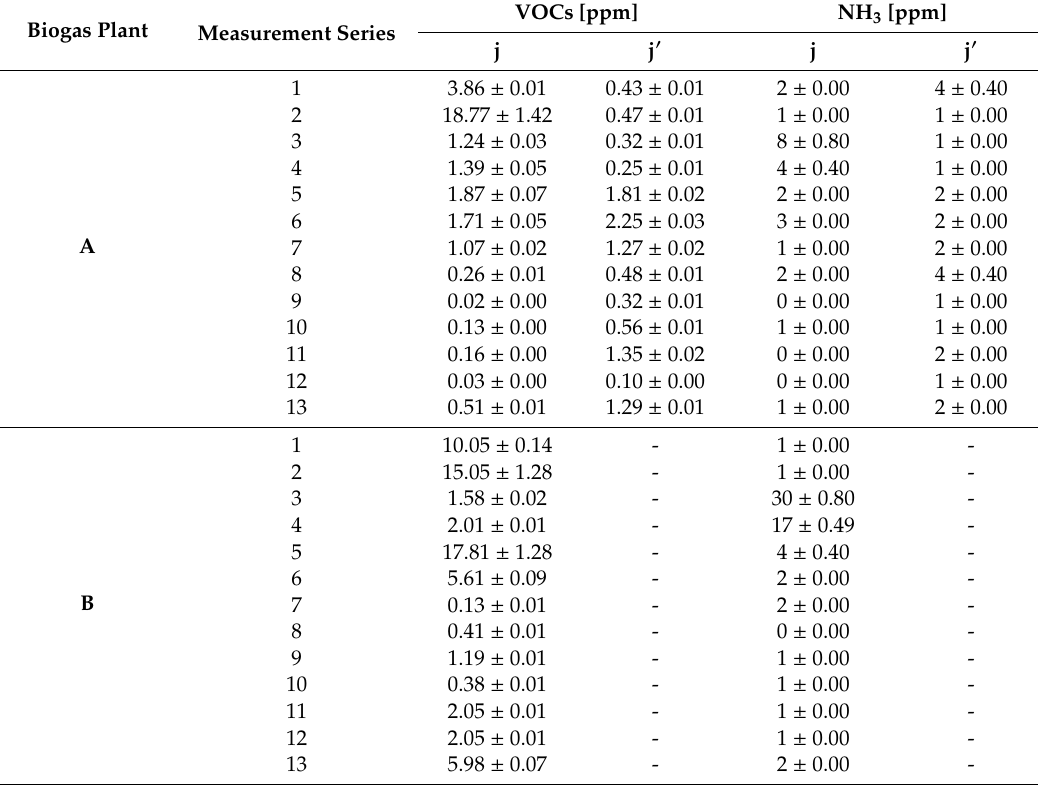
Table 7. Measurement results for the pre-RDF storage technological operation. Biogas Plant